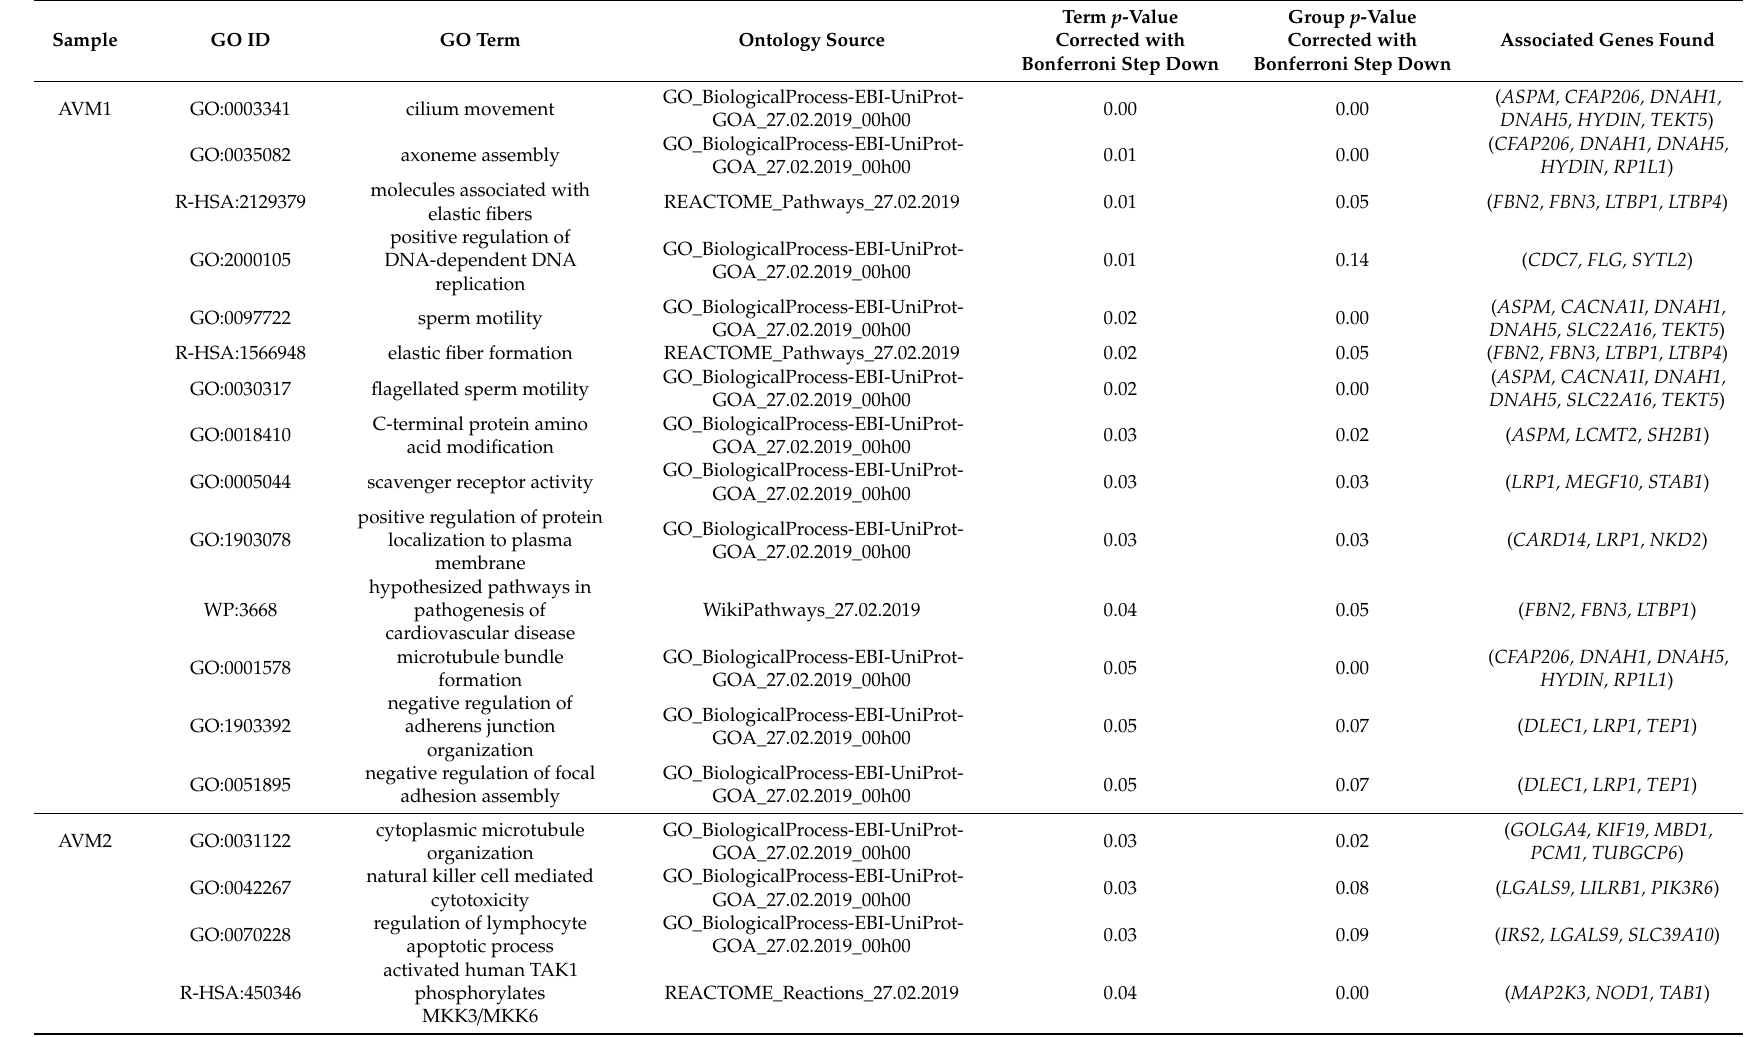
Table 1. ClueGO (Gene Ontology) enrichment analysis